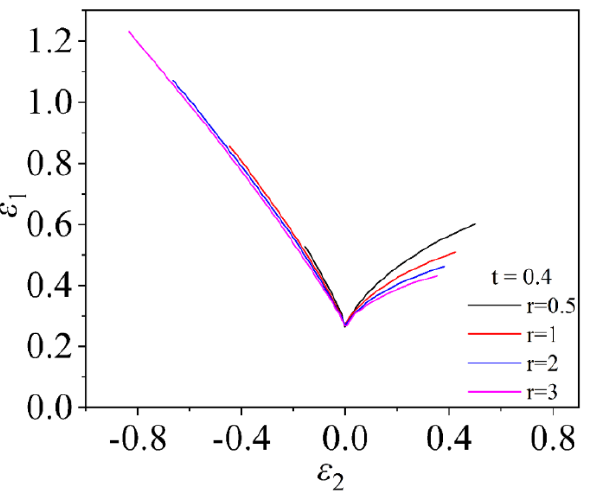
Figure 18. FLD for different r values based on MMFC instability criterion and Hill48 yield criterion at t = 0.4.